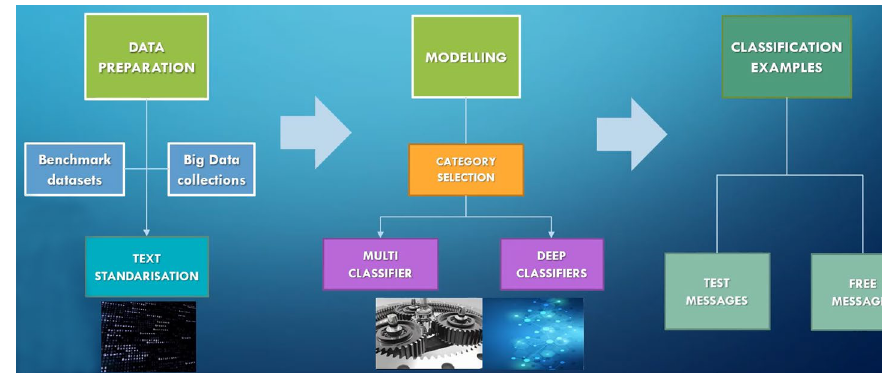
Fig. 1 Schematic Diagram of the proposed Disaster Filter- ing